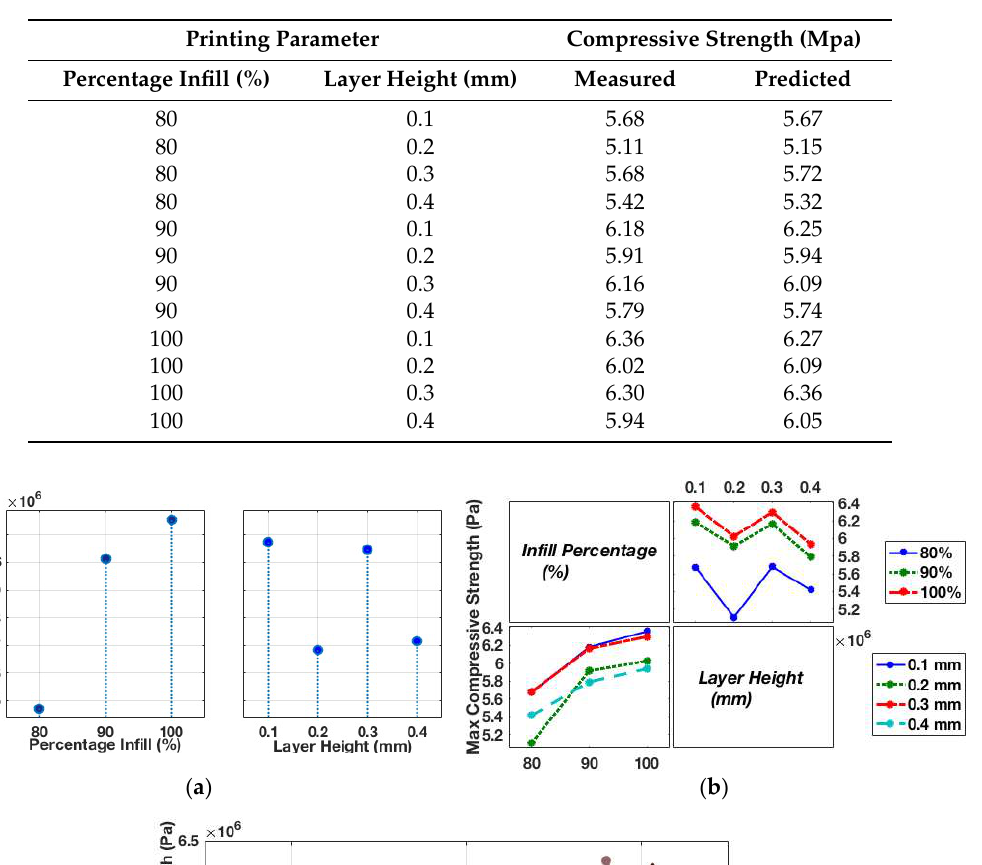
Table 4. Input process parameter and resulting experimental and predicted compressive strength at a high strain rate.